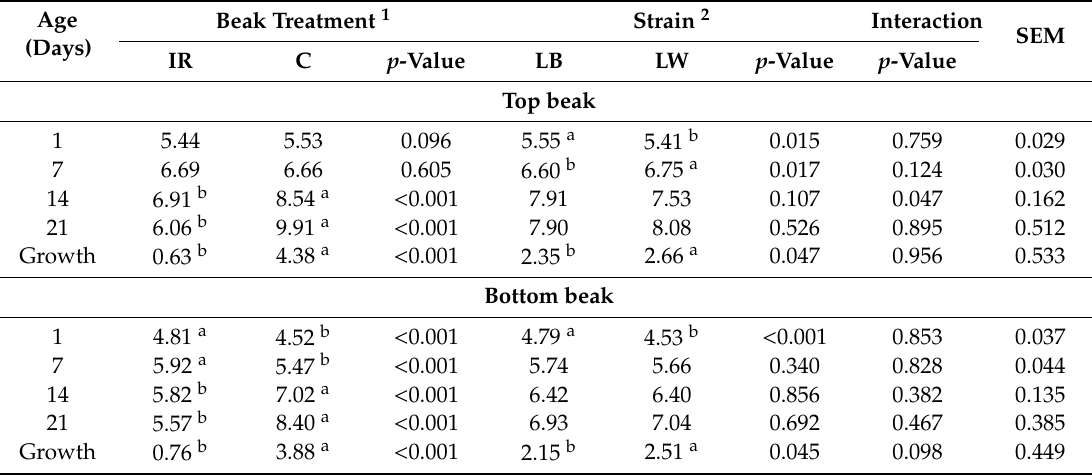
Table 3. E ff ect of infrared beak treatment and strain on the top and bottom beak length and overall beak growth (mm) of Lohmann Brown-Lite and Lohmann LSL-Lite pullets housed in cages from 0 to 21 days of age.